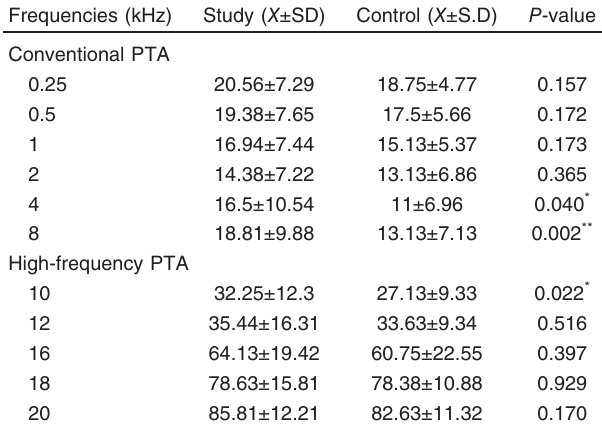
Table 4 Results of pure-tone audiometry (conventional and extended high frequency) in both the study and control groups